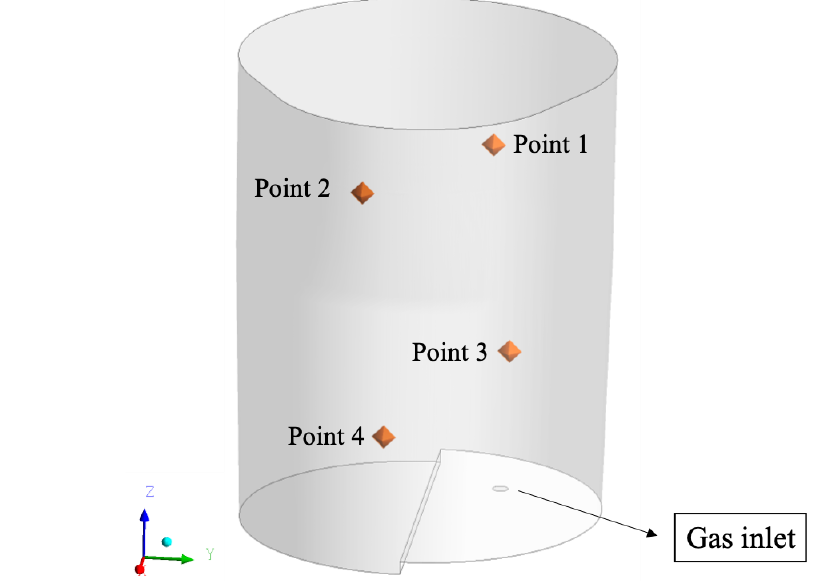
Figure 8. Monitoring points inside the ladle.